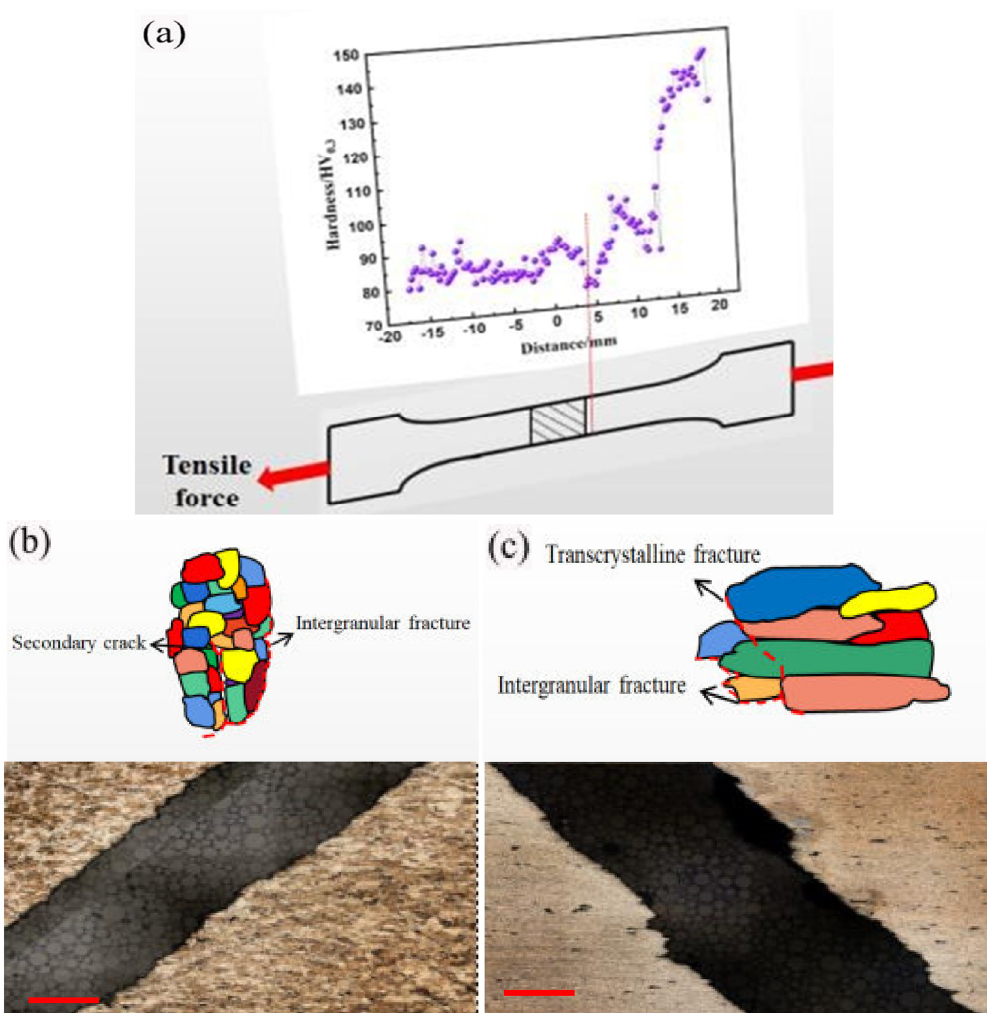
Figure 10. Schematic diagram of crack propagation: ( a ) crack source, ( b ) small-grain zone, ( c ) large- grain zone. ( b , c ): Bar = 200 μ m.